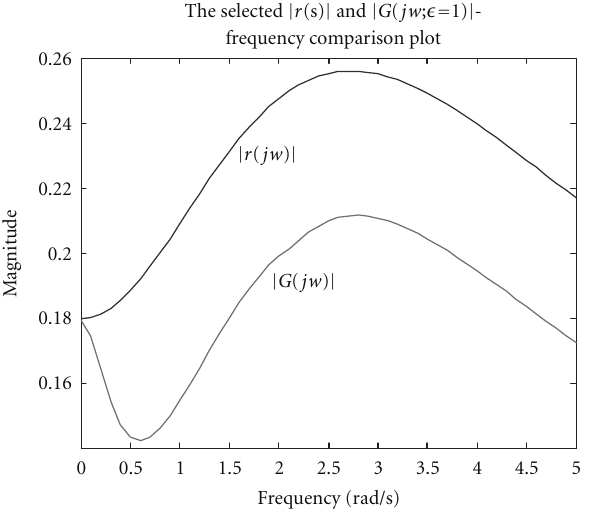
Figure 2: Magnitude of r ( jw ) and the maximum magnitude of Δ G ( ε 1 , jw ).